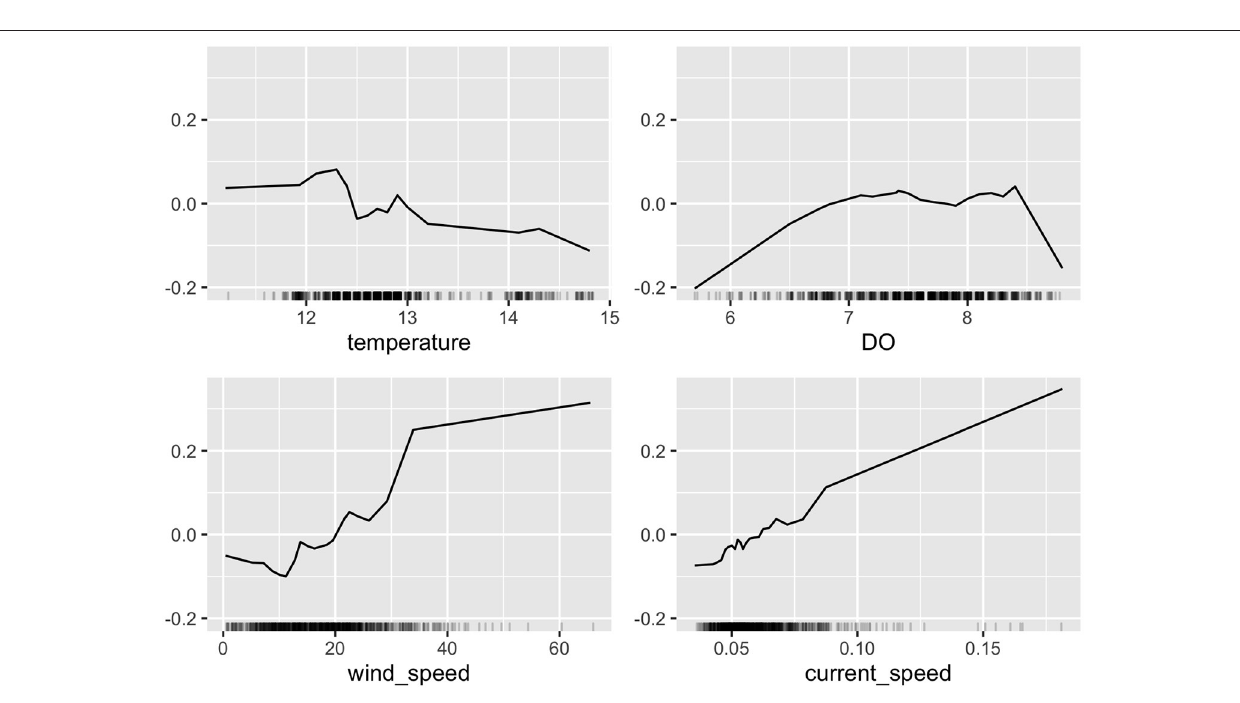
FIGURE 12 | Feature importance reported by the AutoAI model at the CAN site for a subset of environmental variables using accumulated local effects computation. ALE provides an efficient way to explore how much the target variable (fish depth) in response to selected feature (temperature, DO, wind speed, and current speed). The y-axis report the accumulated local effects (ALE) of each feature or variable in the units of the prediction variable ( m ), while the x-axis reports the range of values for each selected feature. Clockwise from top left results are presented for temperature, DO, current speed, and wind speed. ALE is a valuable technique to explore how much predictand varies in response to changes in